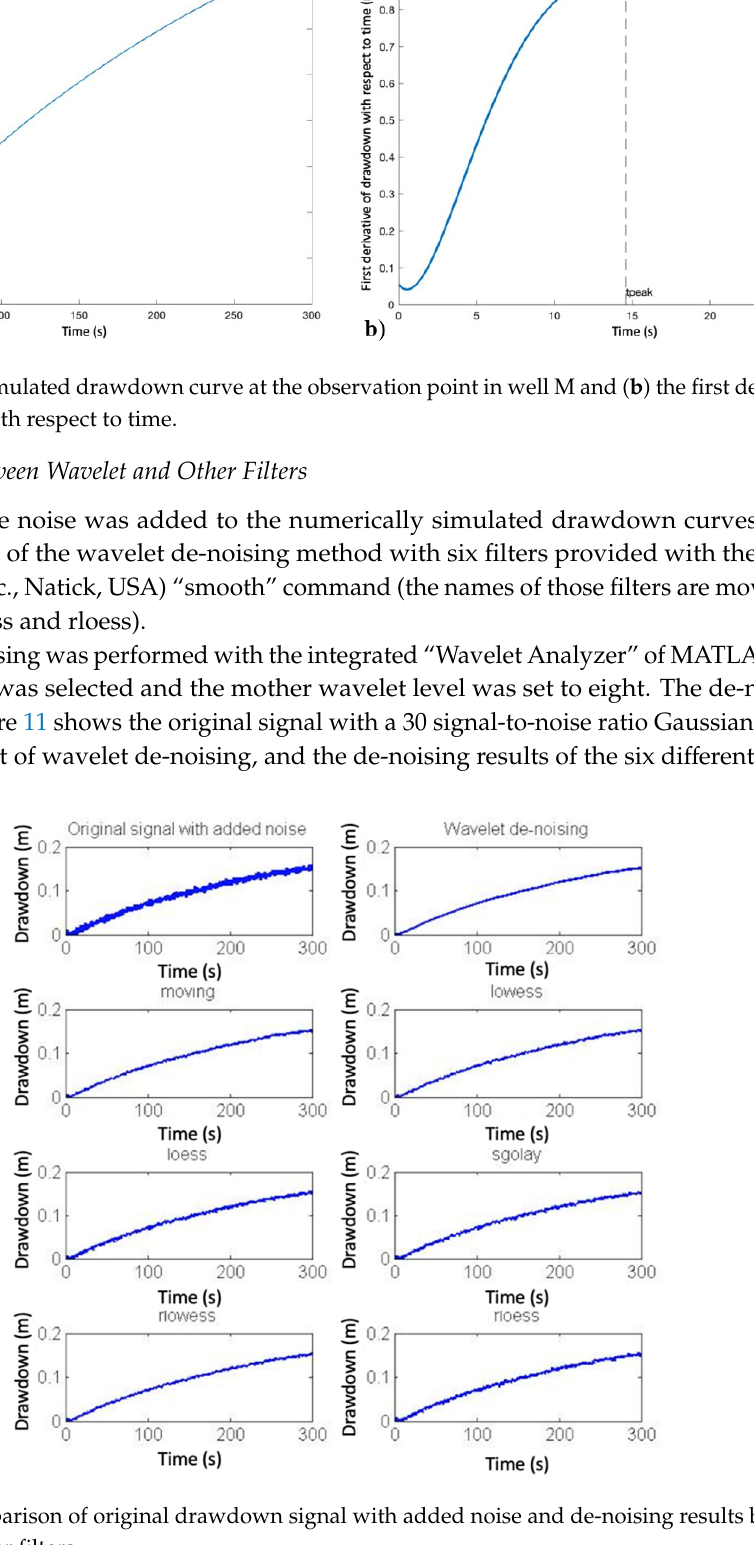
Table 2. Calculated travel time values t peak .